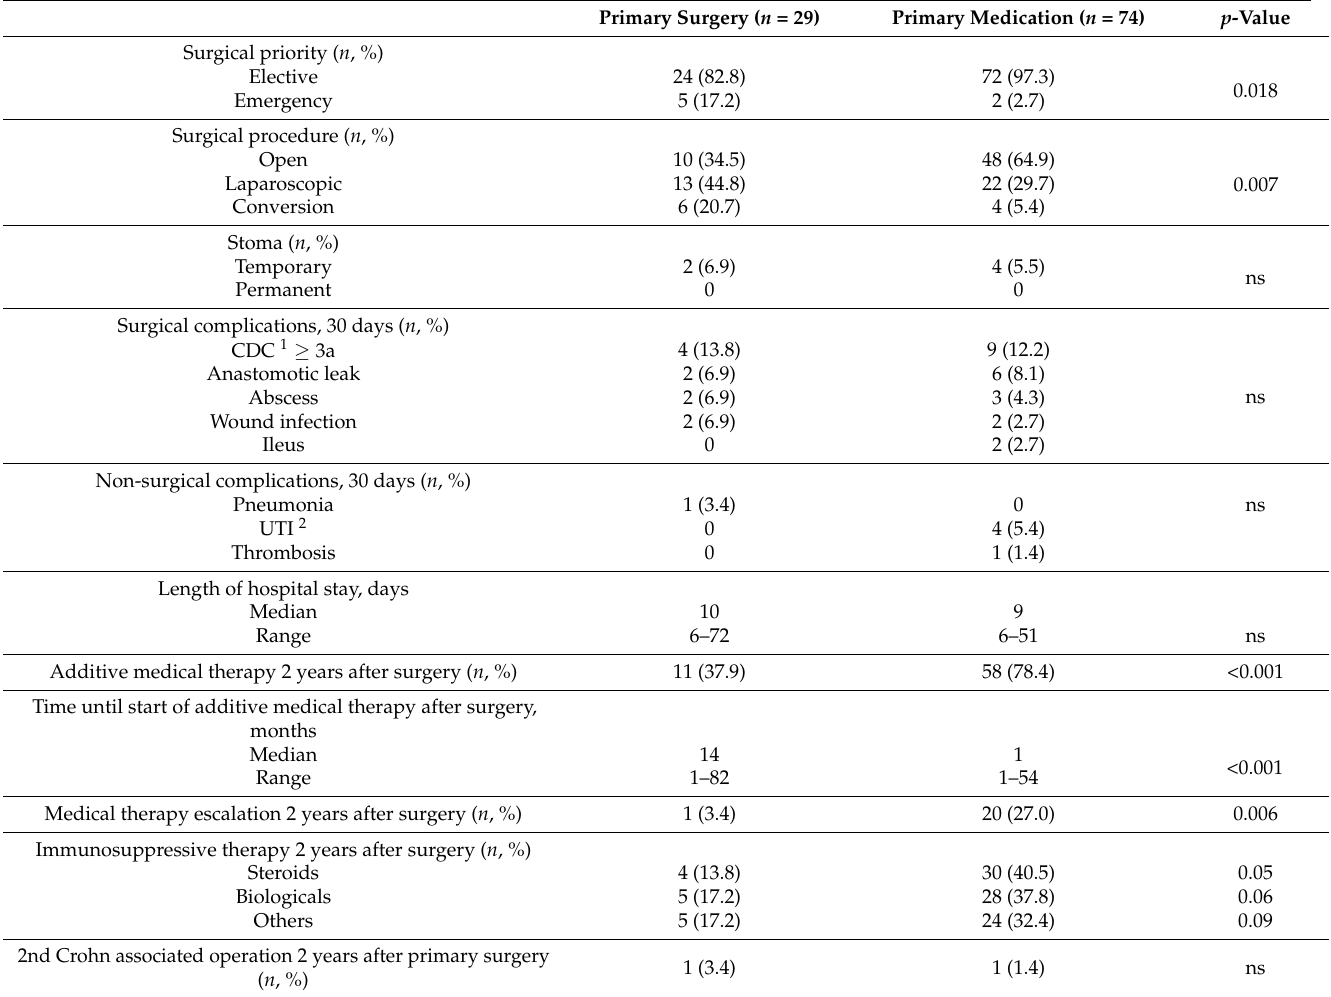
Table 2. Postoperative outcome of all